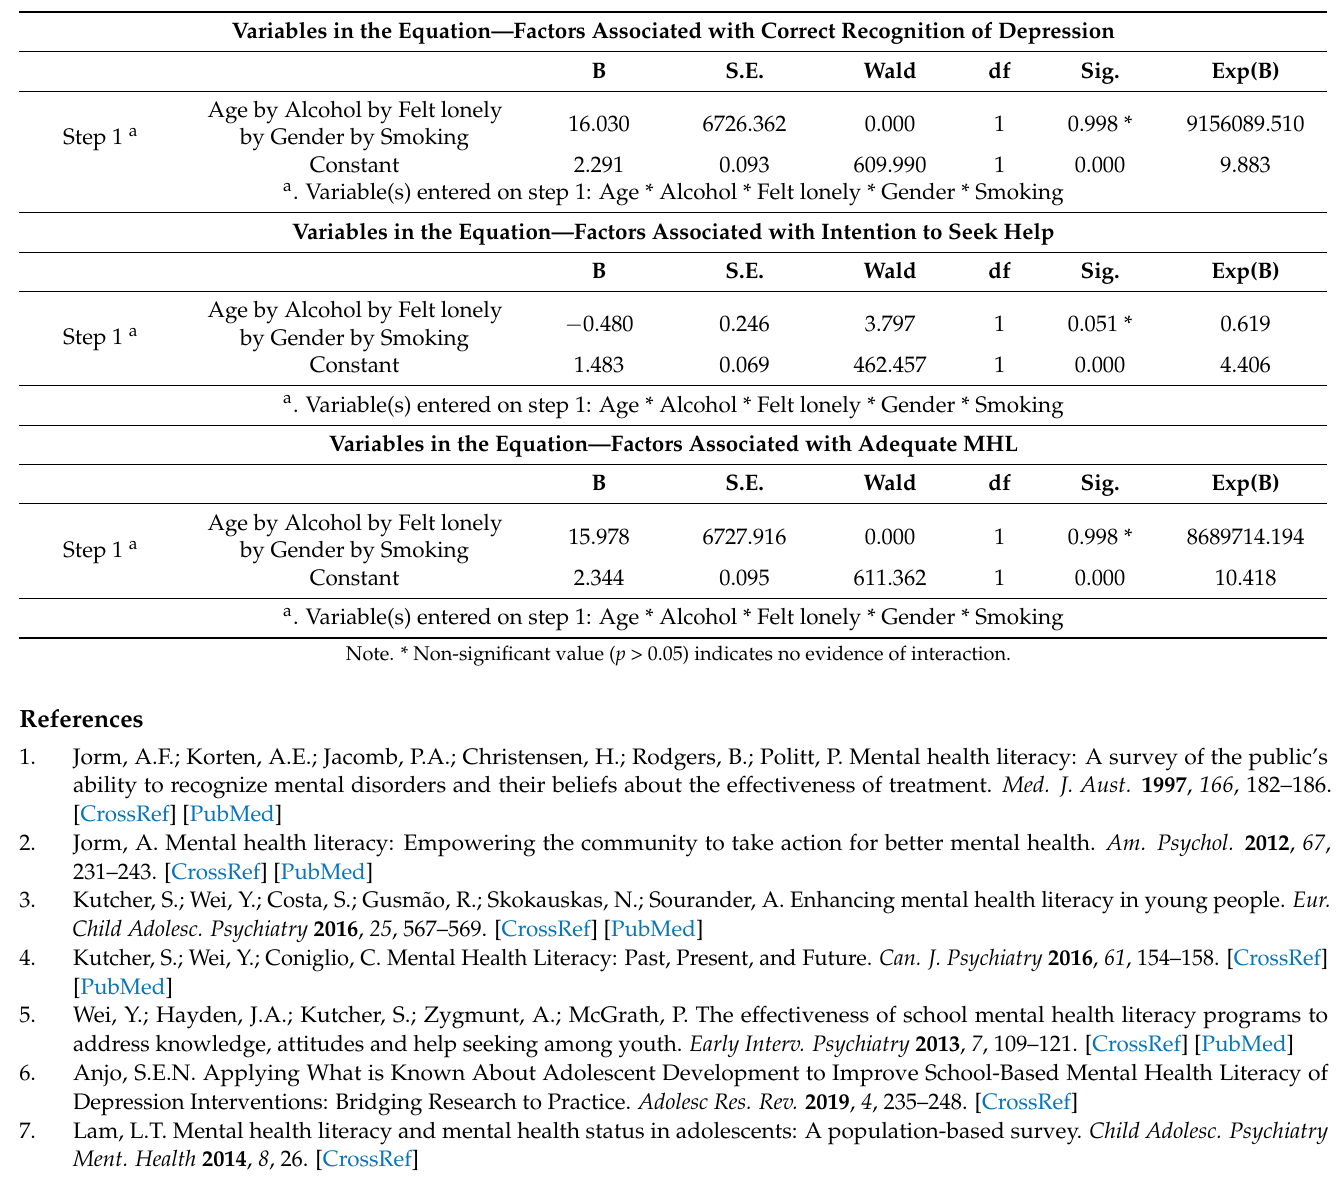
Table A2. Testing for interaction among the independent variables significant at 0.25 in the univariate analysis examining the factors associated with correct recognition of depression/intention to seek help/adequate